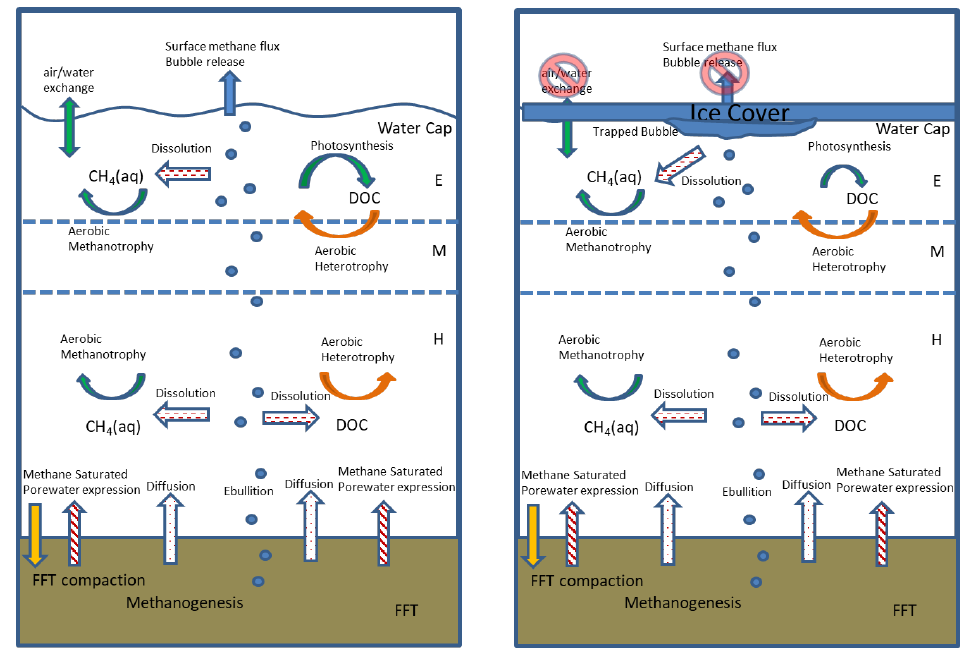
Figure 1. Schematic showing the potential pathways of microbial methane transport and con- sumption within BML under ice-free and ice-covered conditions. The primary distinctions under ice-covered conditions are the lack of loss due to bubble release, and/or the air water partitioning and potential slowing of rates of microbial methanotrophy and, instead, the buildup of bubbles and dissolved methane under the ice. E, epilimnion; M, metalimnion; H, hypolimnion.